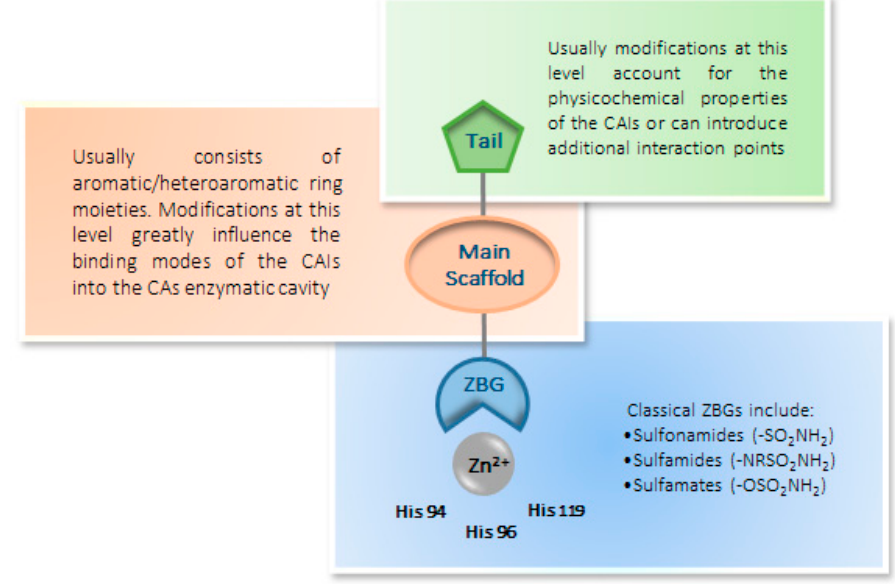
Figure 1. The ring and the tail approaches used for the specific inhibition of the carbonic anhydrases.